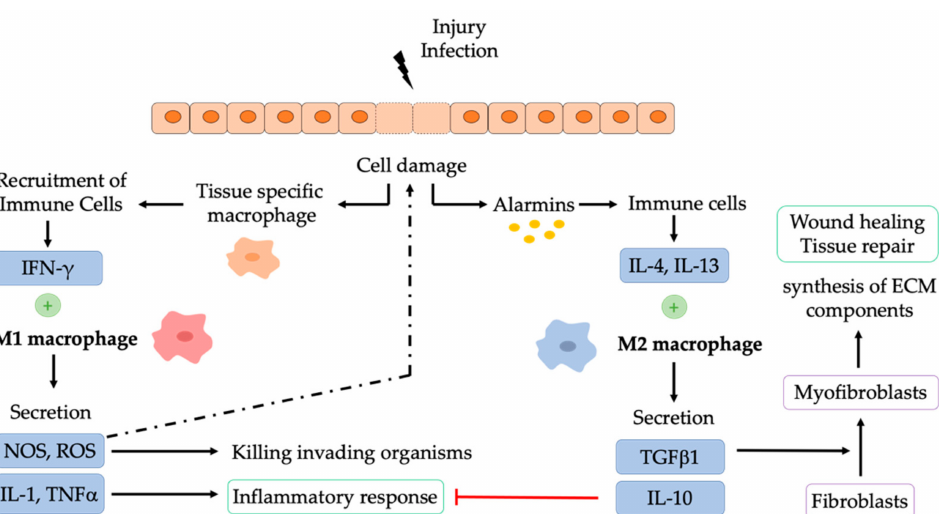
Figure 2. Macrophage activation by injury or infection. Cell damage triggers the activation of the im- munological response, which is characterized by M1 macrophage accumulation. M1 macrophages trigger pro-inflammatory signals that are balanced by M2 macrophages (those that mediate anti-inflammatory responses and wound healing). IL: Interleukin; TGF- β : tumor growth factor beta; IFN- γ : interferon gamma; TNF α : tumor necrosis factor alpha; NO: Nitrogen oxide; ROS: Reactive oxygen